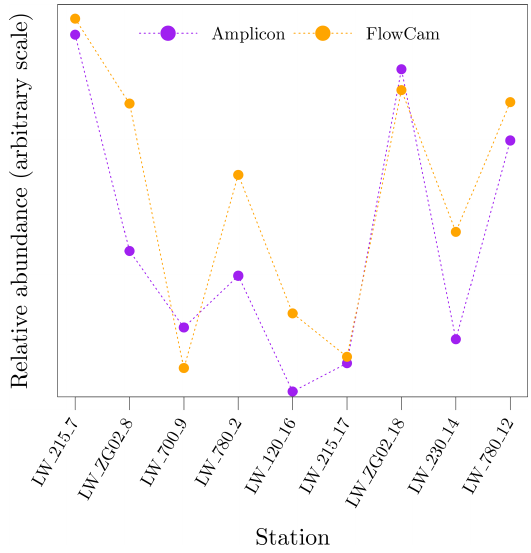
Figure 14. Relative abundance of Rhizosolenia spp. cells as es- timated by DNA metabarcoding (amplicon sequencing) and mi- croscopy (FlowCam). Data normalised using the counts of common species of diatoms in each